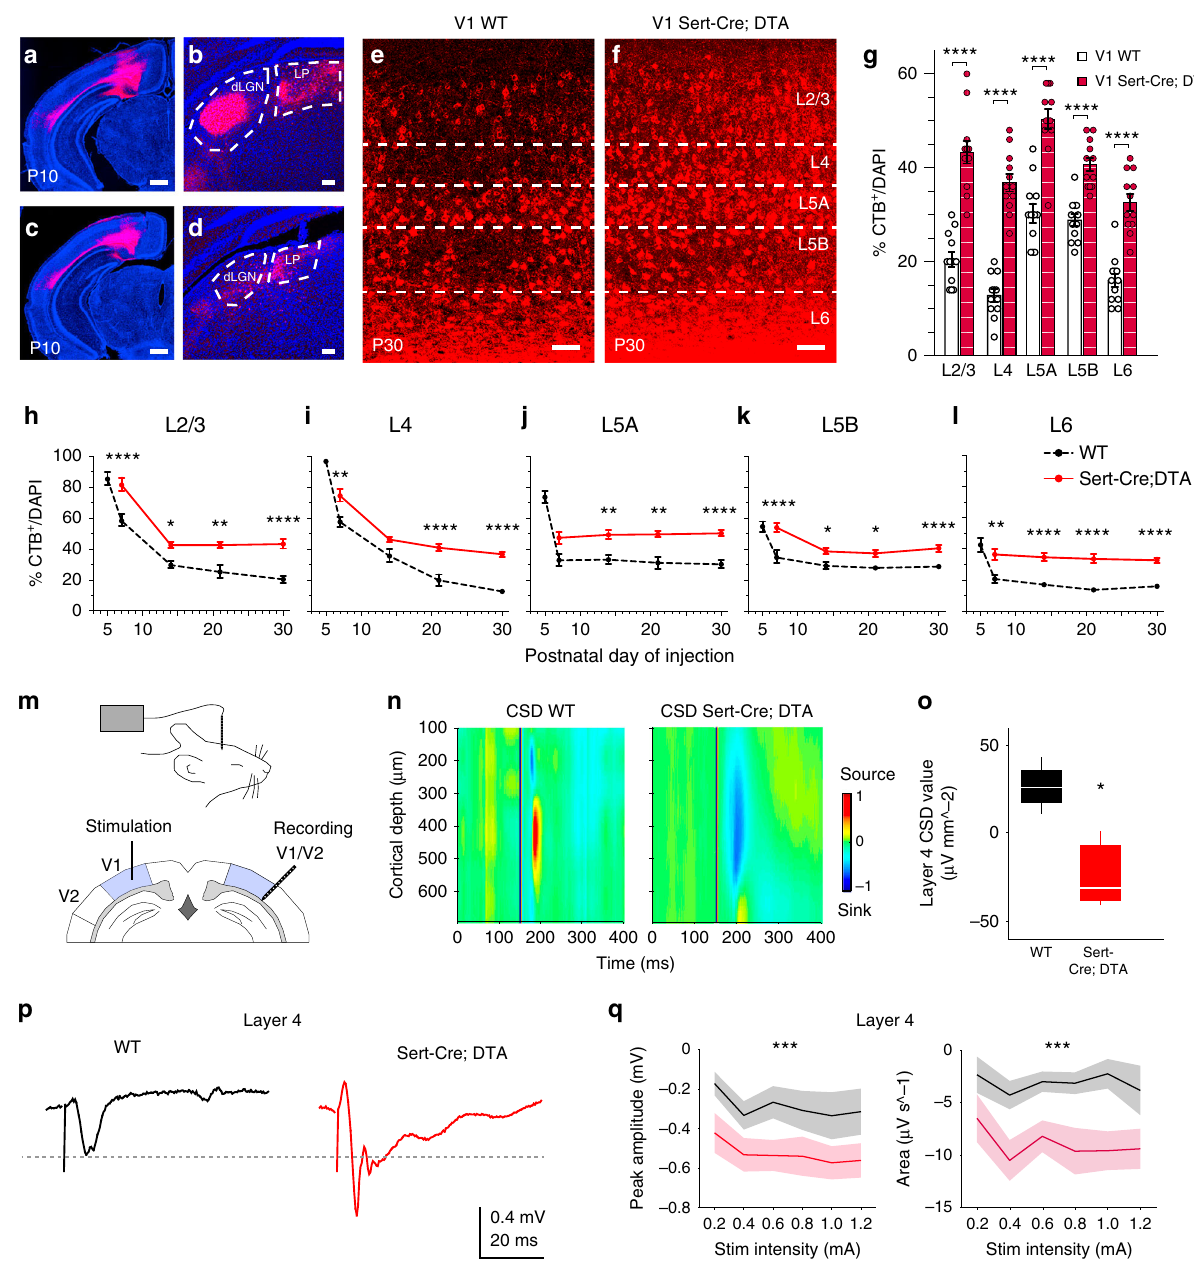
Fig. 7 Elimination of thalamic input increases interhemispheric connectivity in the visual cortex. a – d Cortex and thalamus of WT ( a , b ) and Sert-Cre;DTA ( c , d ) after injections of CTB in V1 cortex. Dashed lines delineate thalamic nuclei ( b , d ). e , f CTB + neurons (red) in P30 V1 cortex after callosal injections. Scale bars: 500 µ m ( a , c ) and 100 µ m ( b , d – f ). g Quanti fi cations of CTB + cells after CC injections in adult mice ( n = 6 animal per condition) (WT data